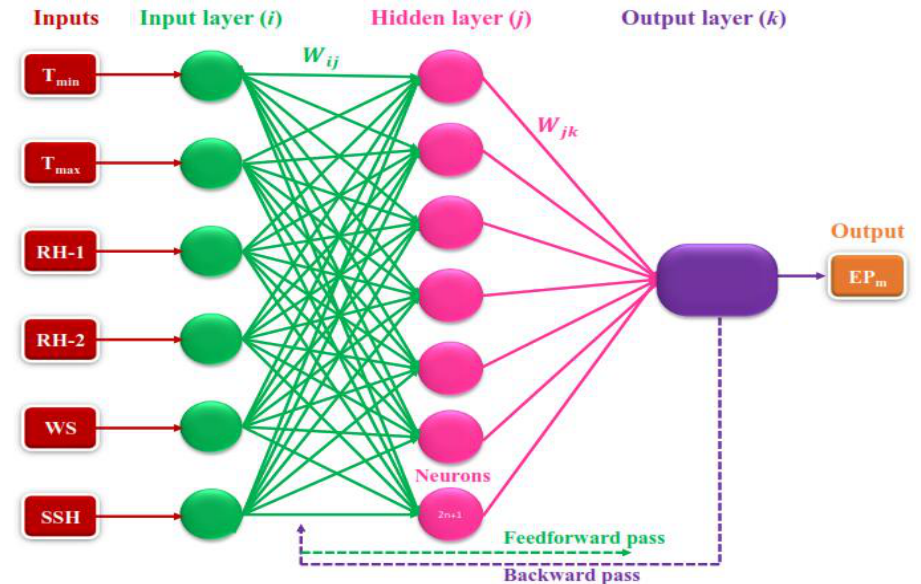
Figure 4. Configuration of the three-layer multilayer perceptron neural network (MLPNN) model.